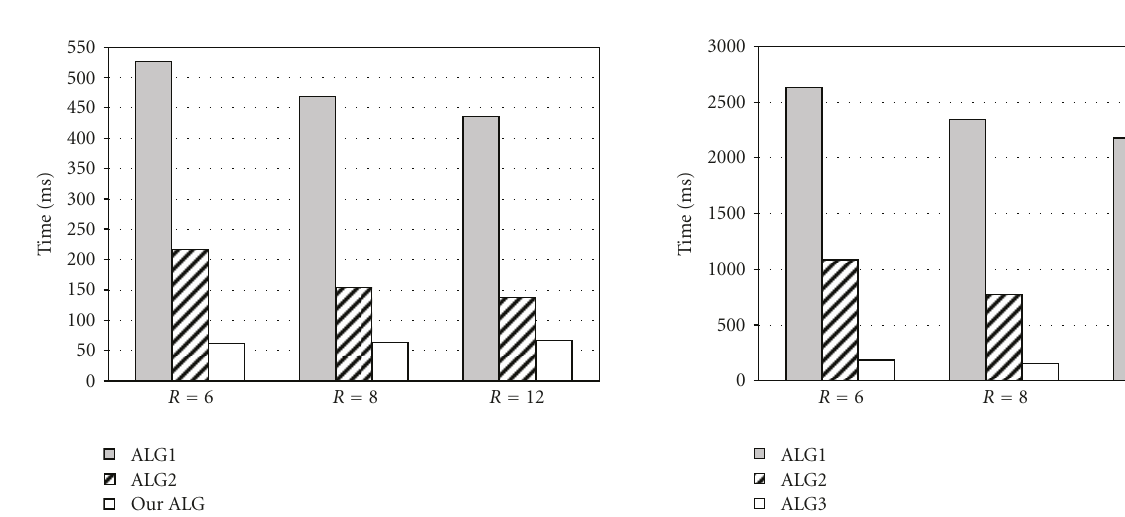
Figure 9: Average time to find one proxy with low connectivity (data rate = 250 Kb/s; P actual = 30%).